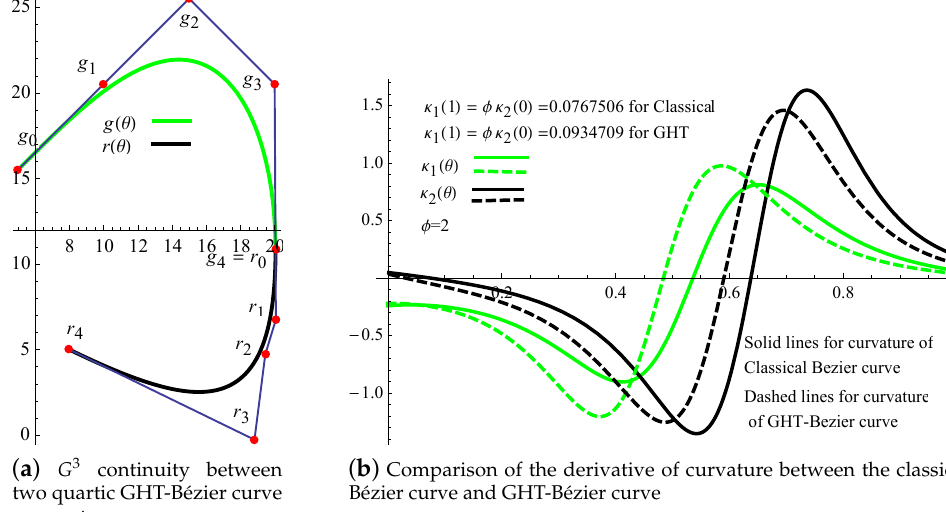
( b ) Comparison of the derivative of curvature between the classical Bézier curve and GHT-Bézier curve